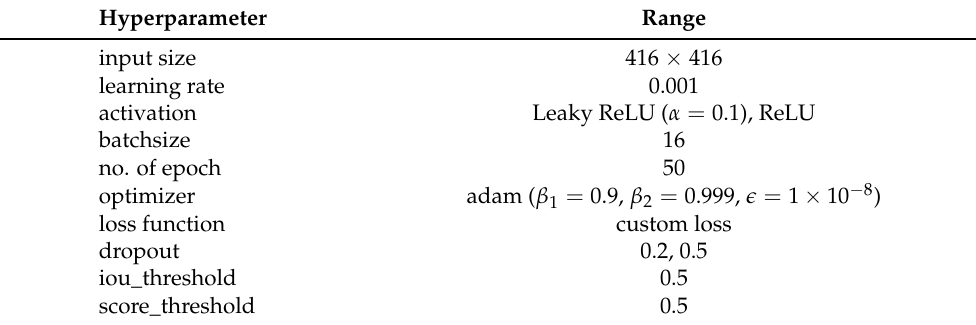
Table 2. Hyperparameters used in the